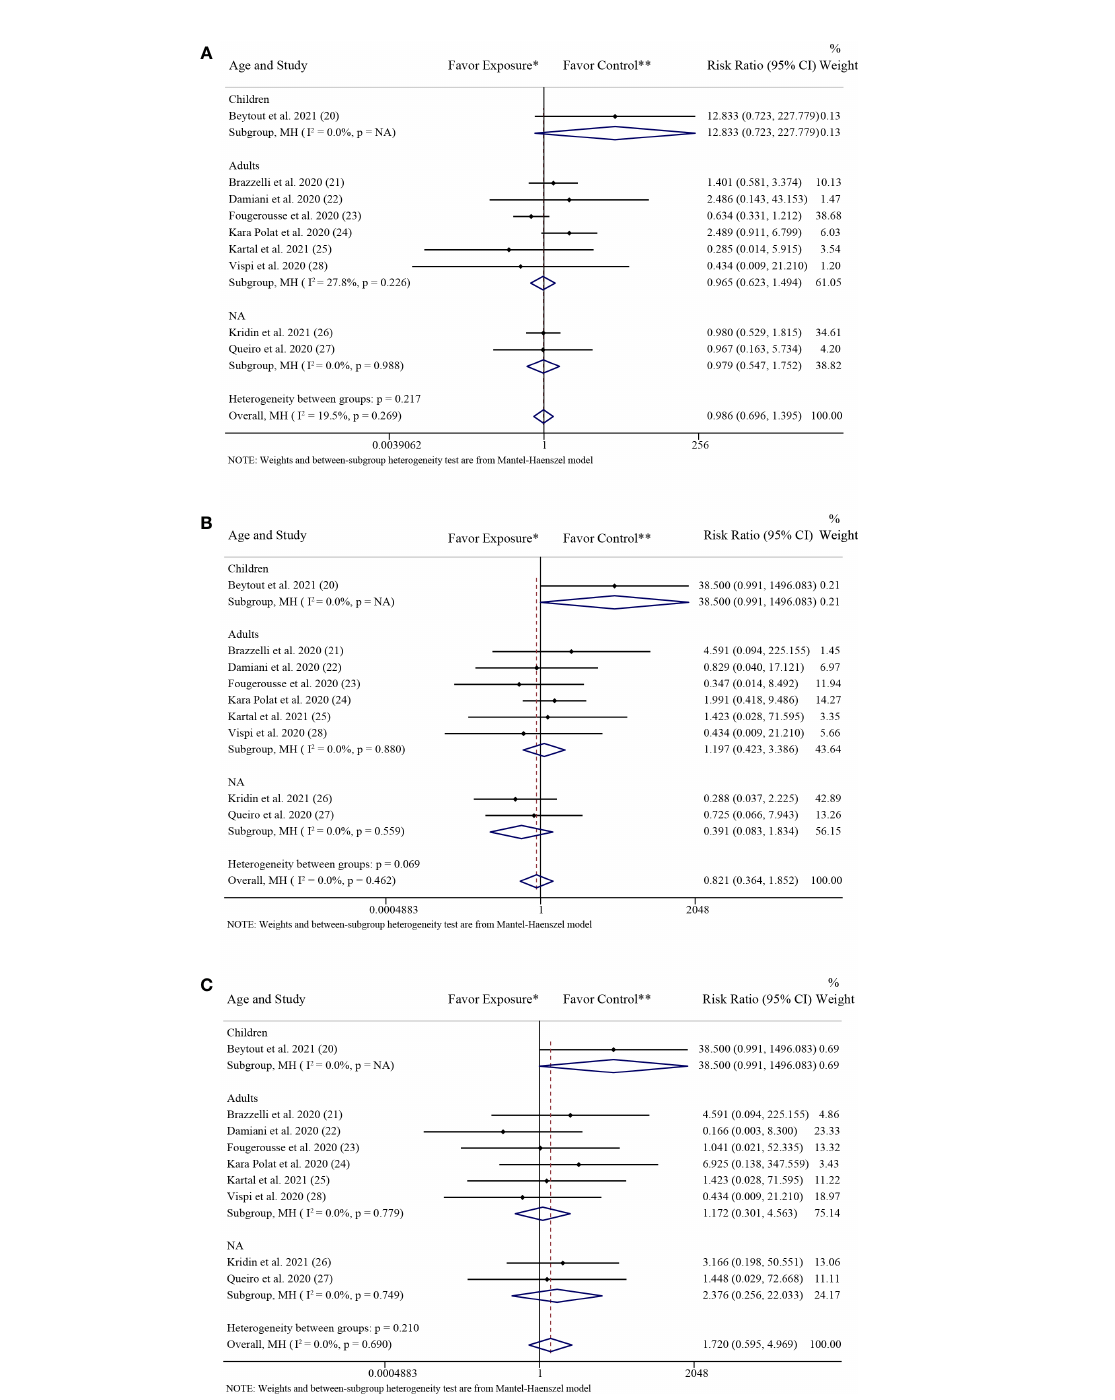
FIGURE 4 Subgroup analysis grouped by age. (A) Forest plot of risk ratios and 95% CIs of the SARS-CoV-2 infection rate; (B) Forest plot of risk ratios and 95% CIs of the COVID-19 hospitalization rate; (C) Forest plot of risk ratios and 95% CIs of the COVID-19 mortality rate. CI , con fi dence interval; COVID-19 , coronavirus disease 2019; MH , Mantel-Haenszel method; NA , not available. *Exposure represents patients with psoriasis treated with IL-17 inhibitors. **Control represents patients with psoriasis treated with